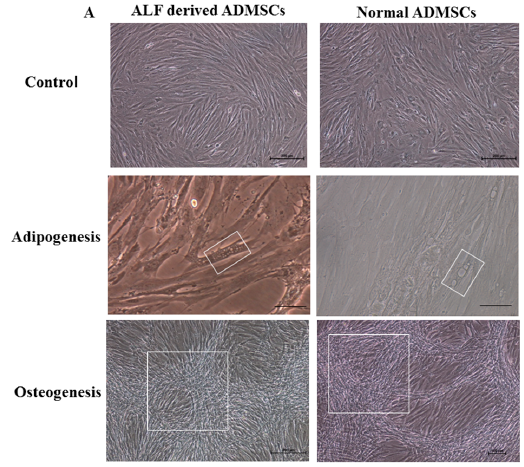
Figure 6. Cont. Figure 6.